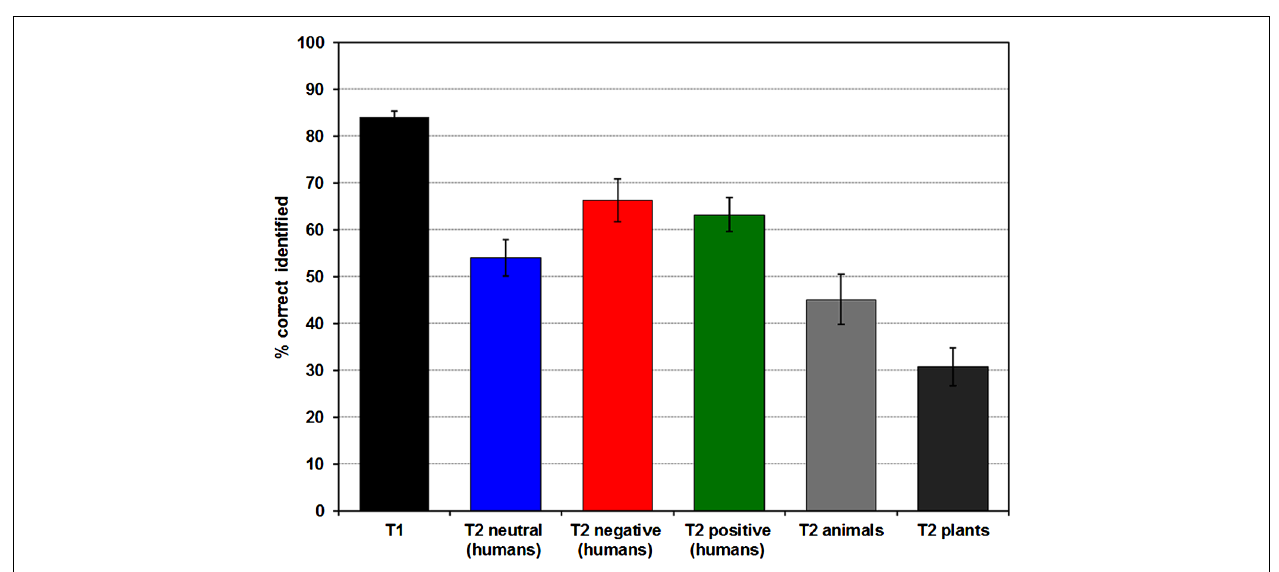
FIGURE 2 | Diagram of mean percentage (and standard error) of correctly identifiedT1 andT2 pictures. T2s were only included when the precedingT1 was detected correctly.